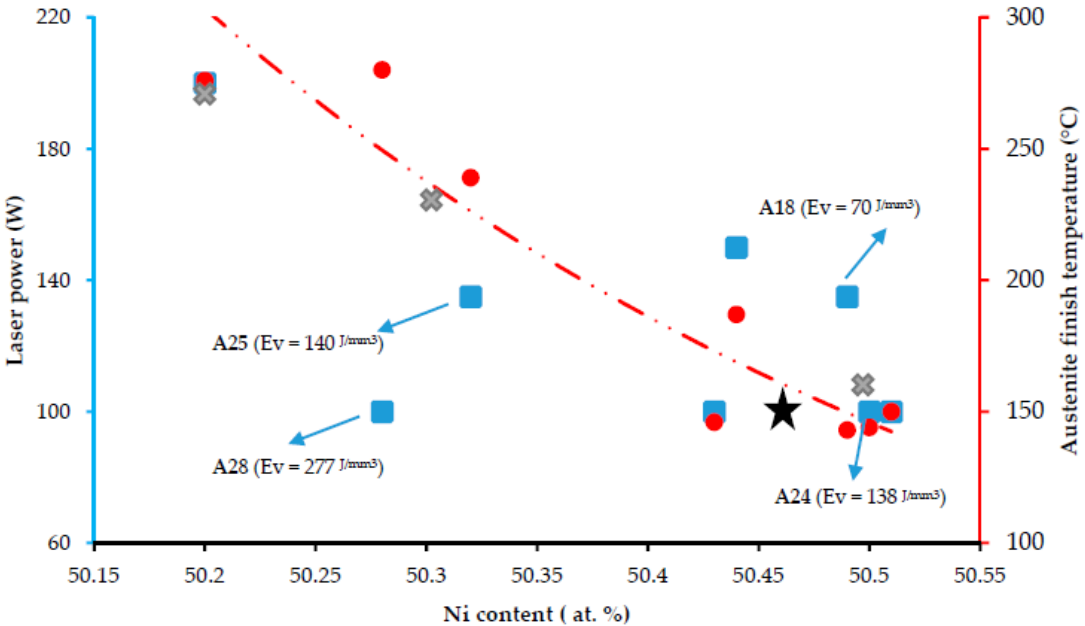
Figure 7. A f (circles) and laser power (squares) as a function of measured Ni content after fabrication. Red dotted line shows the trends of A f and the star shows powder A f and Ni content. Cross shapes show the A f of the homogenized NiTiHf 20 samples with different Ni contents from [64]. Figure 8 shows the XRD spectra of NiTiHf powder, sample A2 (E v = 59.5 J/mm 3 ) and sample A10 (E v = 127.5 J/mm 3 ) at room temperature. The powder shows a fully martensitic phase at room temperature, which confirms the DSC results showing martensite finish temperature near 80